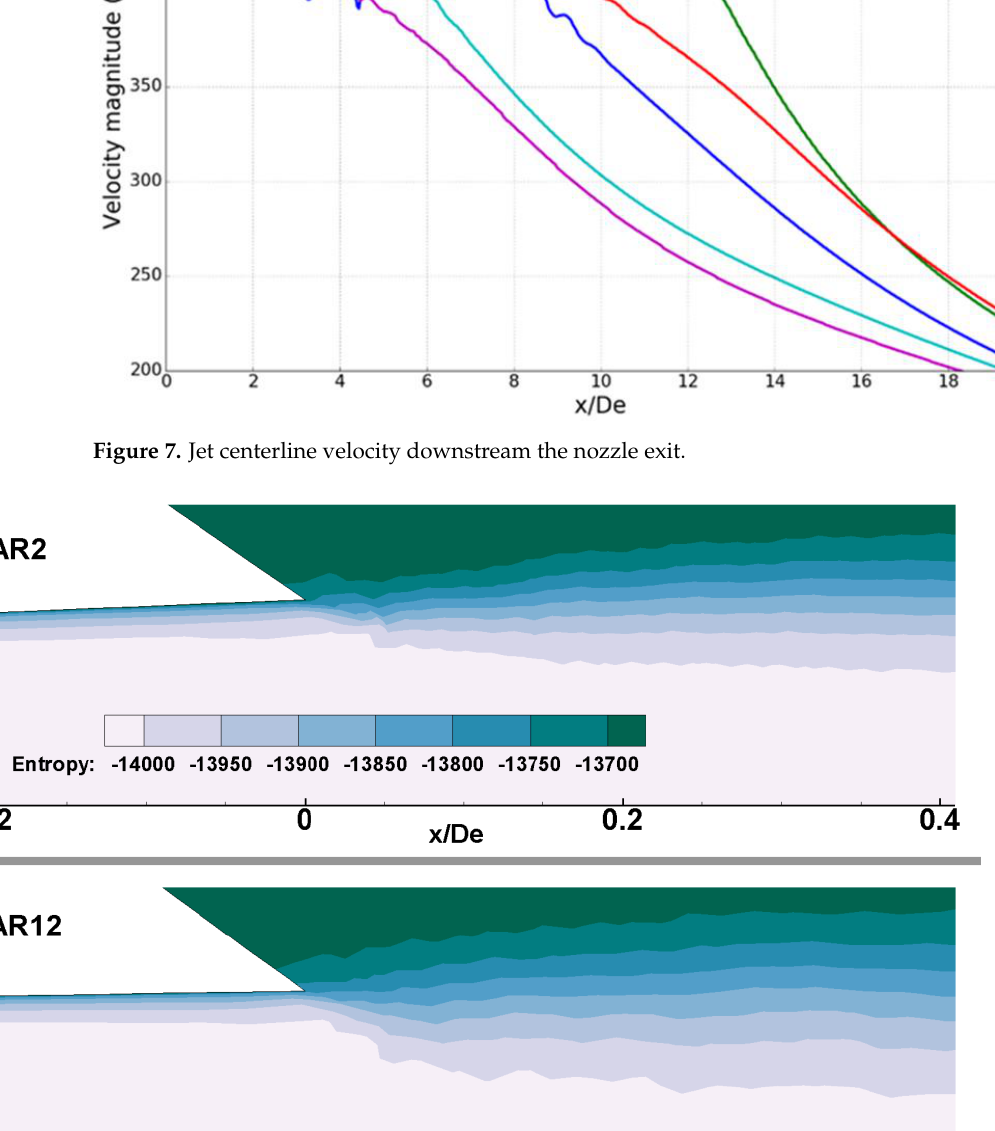
( a ) Contours of turbulent kinetic energy TKE (J/kg)